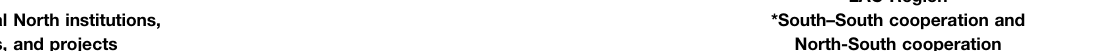
TABLE 1 | Examples of science diplomacy capacity building institutions, bodies, and training Global *Global North institutions, bodies, and